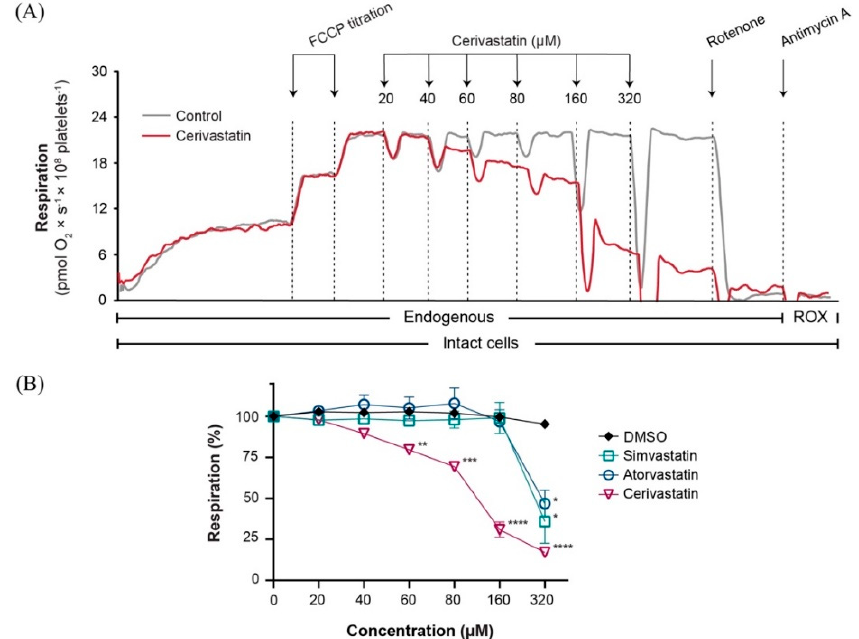
Figure 1. Statins induced a concentration − dependent inhibition of mitochondrial respiration in intact human platelets. ( A ) Representative traces of cerivastatin (red) and DMSO (grey) titration. Respiration of human platelets was measured after sub-maximal uncoupling with FCCP (2 µM). ( B ) The concentration-dependent effect of simvastatin (open square), atorvastatin (open circle) and cerivastatin (open triangle) was measured by titrating increasing concentrations of statin or vehicle (DMSO) (black rhombus). Data is expressed as mean±SEM. FCCP, carbonyl cyanide p-(trifluoromethoxy) phenylhydrazone; DMSO, dimethyl sulfoxide; ROX, residual oxygen consumption. Two-way ANOVA with Bonferroni post hoc test was performed on antimycin-corrected data. * p < 0.05; ** p < 0.01; *** p < 0.001; **** p < 0.0001 vs. DMSO.